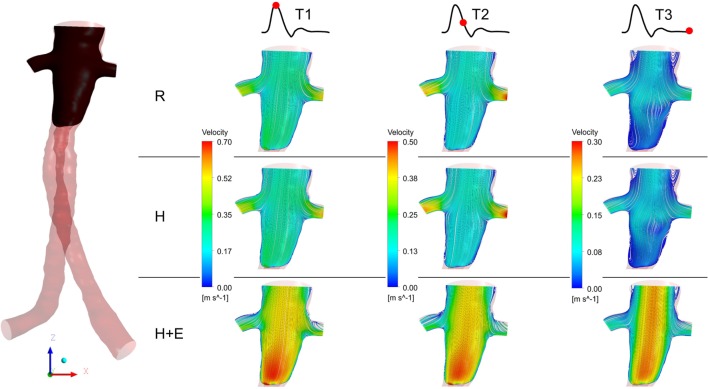
Instantaneous velocity streamlines plotted at a cut plane in the coronal plane during T1, T2, and T3. The location of the cut plane is shown in the fenestrated stent graft on the left. R refers to the resting conditions, H refers to the hypertension simulations, while H + E refers to exercise conditions simulated for hypertensive subjects. It can be noticed that the velocity streamlines throughout the entire cardiac cycle during resting and hypertension scenarios are very similar to one another, while the highest flow velocity was observed during the exercising conditions.